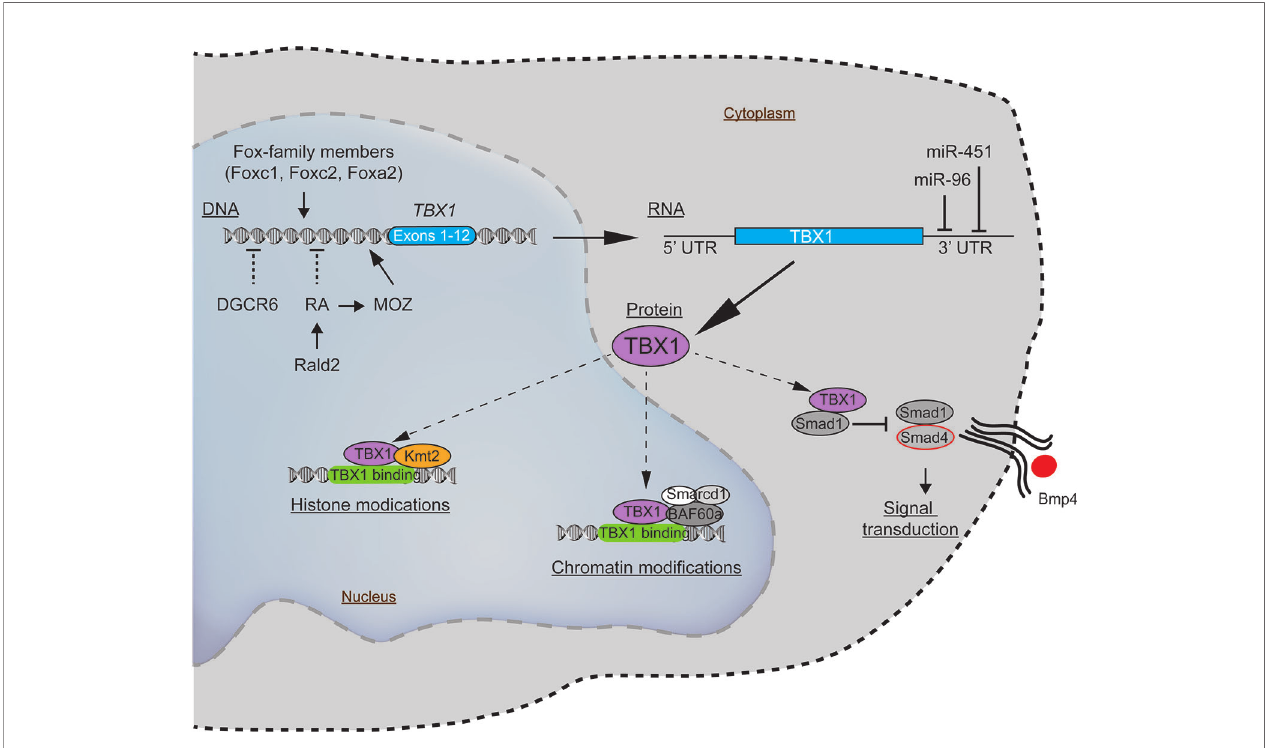
FIGURE 2 | Molecular pathways intersecting with TBX1 with the potential to modulate the clinical severity and penetrance of 22q11.2del. The expression of TBX1 , a key gene coupled to the patterning of the pharyngeal apparatus, is positively regulated by members of the Fox-family of transcription factors and MOZ. Negative regulators of TBX1 include the de fi ned teratogens, retinoic acid (RA), gestational diabetes, and miR-96 and miR-451a, the latter two miRNAs that target the 3' untranslated region of TBX1, resulting in its degradation. While most TBX1 resides in the nucleus, wherein it can regulate gene expression, a fraction of TBX1 is localized in the cytosol, where it negatively impacts bone morphogenic protein signaling via a complex with